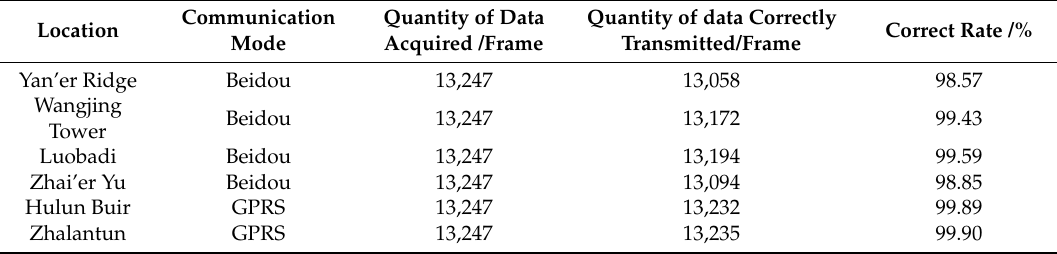
Table 3. The communication result of forest microclimate station.